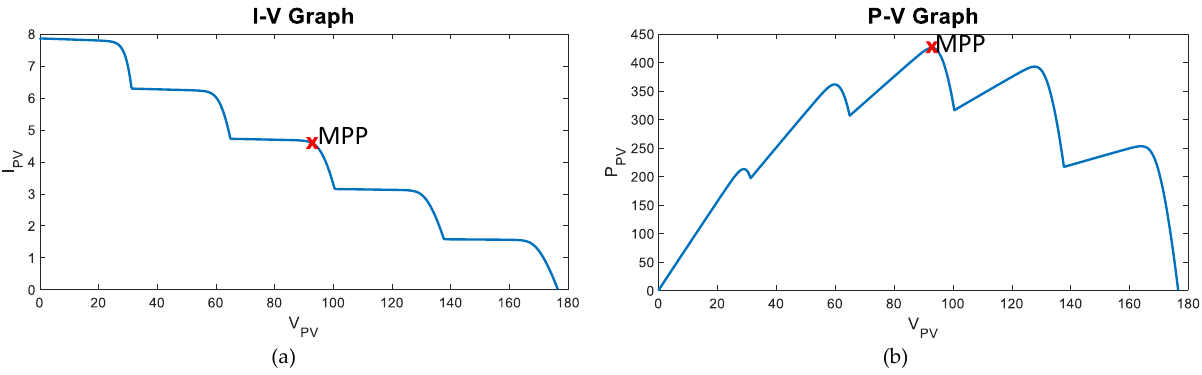
Figure 10. ( a ) I-V and ( b ) P-V characteristic curves of PV panel underneath partial shading condi- tion.